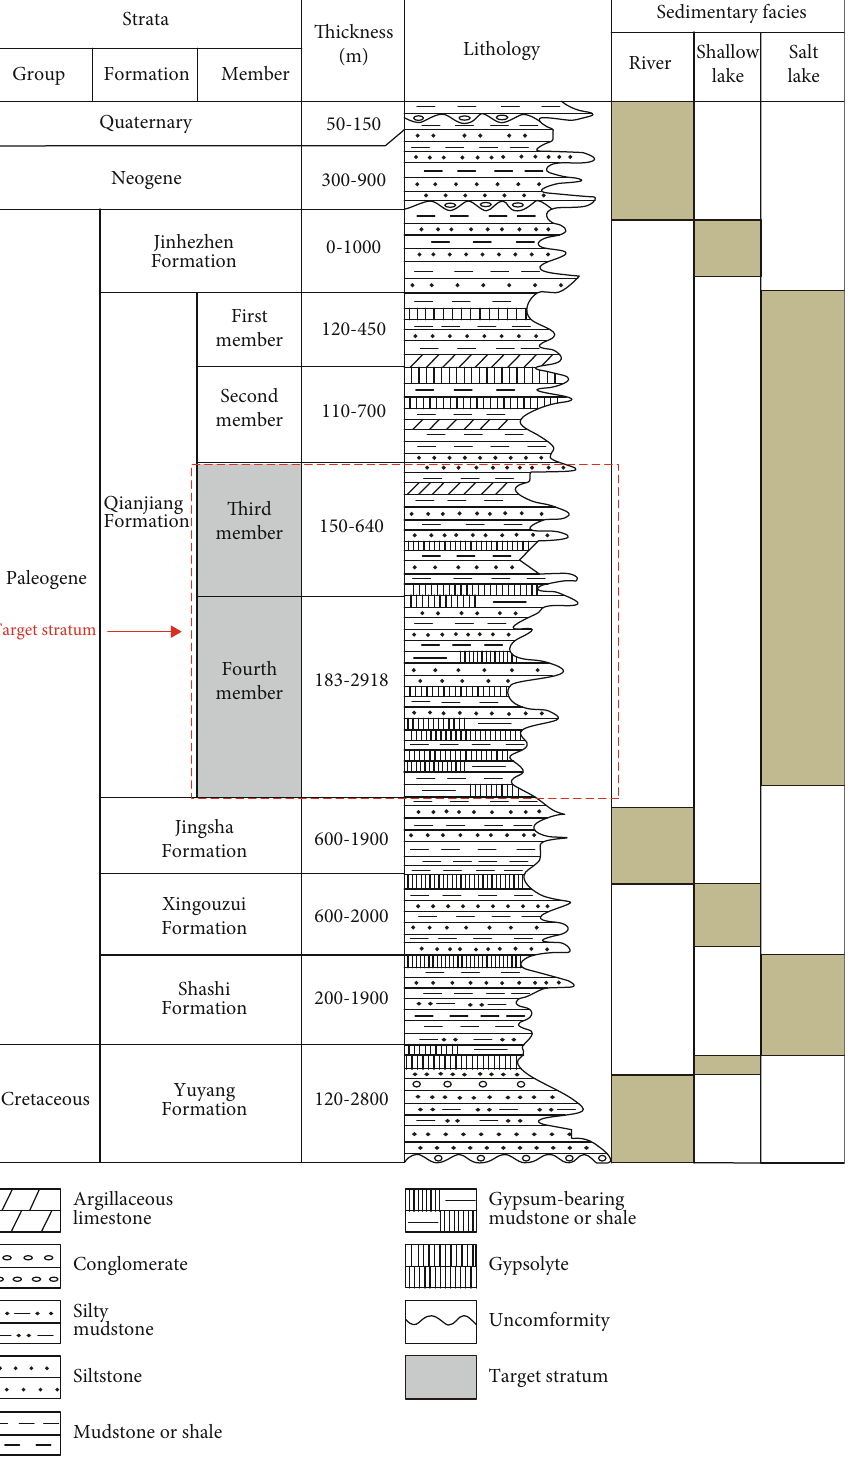
Figure 2: Stratigraphic column in the Qianjiang Depression (modi fi ed from Bai et al.,